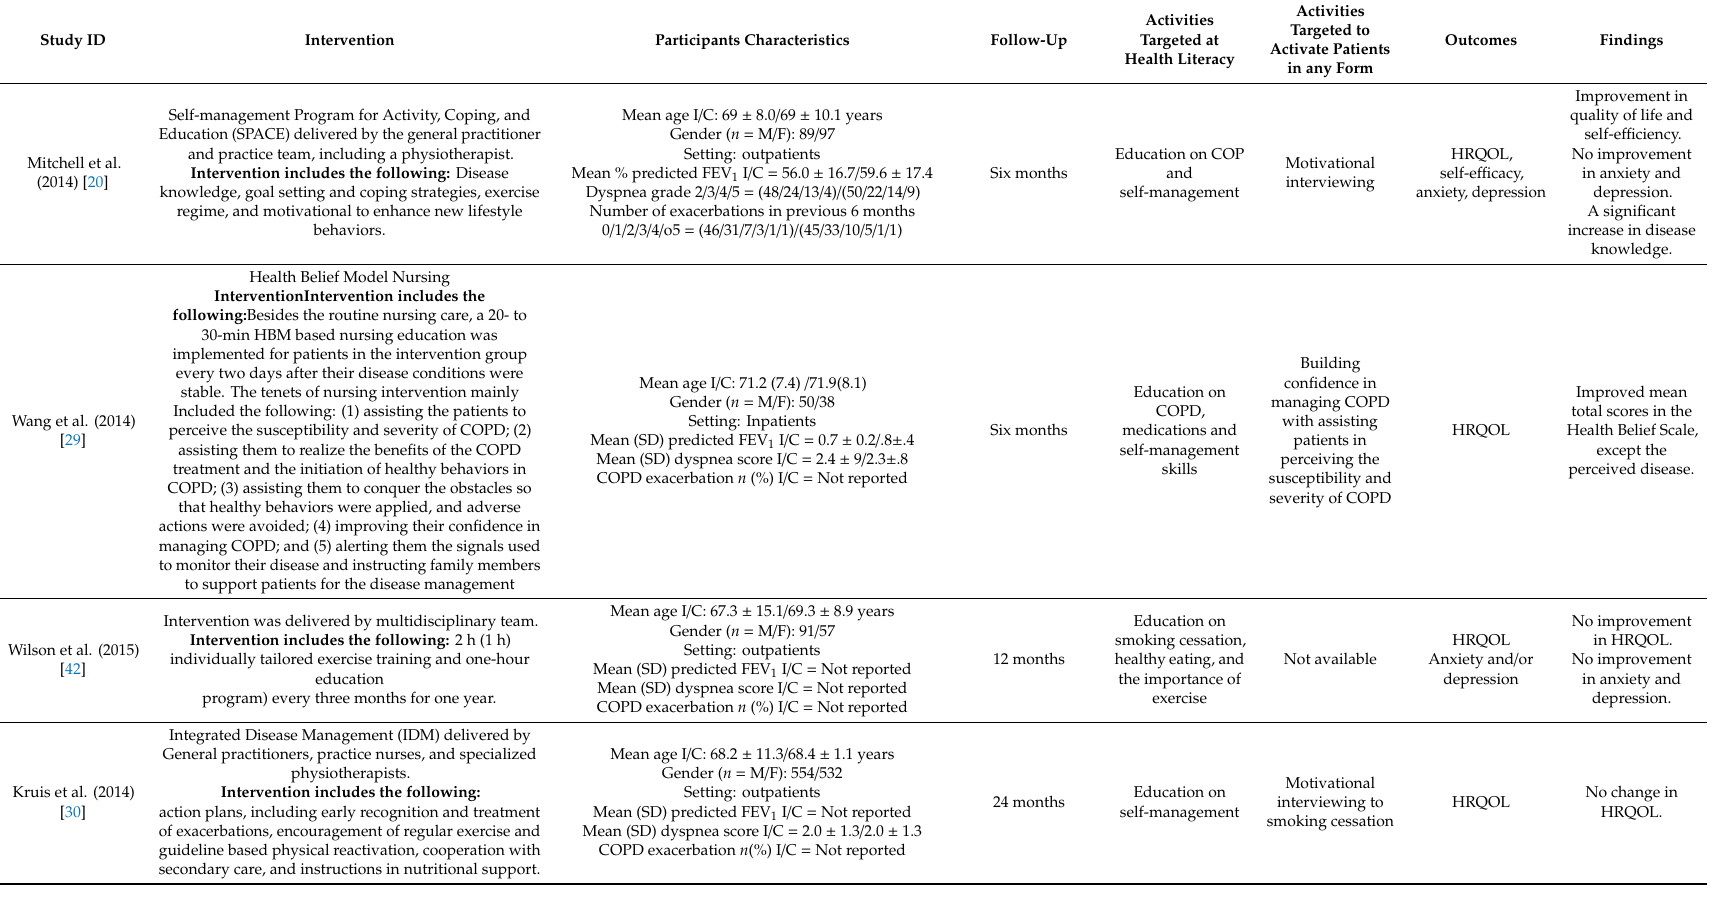
Study ID Intervention Participants Characteristics Follow-Up